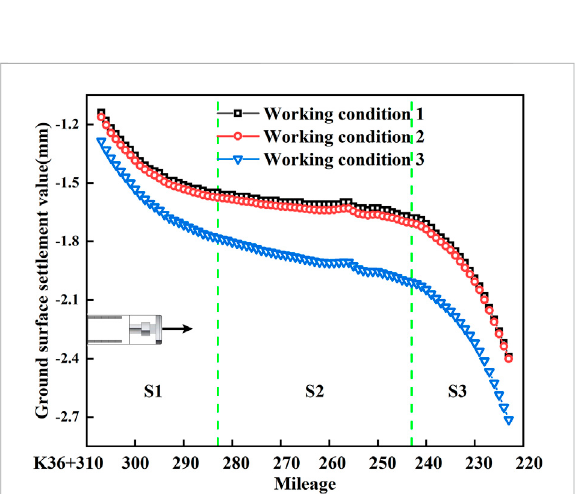
FIGURE 13 Ground settlement at the centerline in two tunnels under working conditions 1 and 2.